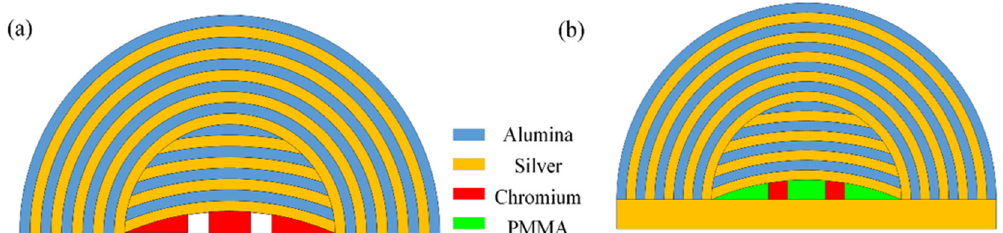
Figure 2. ( a ) Chromium is filled into the radian space of the hyperlens. Two nano-slits are set as objects and the center-to-center distance is set as a variable to investigate the imaging resolution. ( b ) Two chromium cuboids are placed into a plasmonic resonant cavity of our hyperlens and the rest space of the cavity is filled with PMMA. The center-to-center distance between the two cuboids is also set as a variable to explore the imaging resolution.